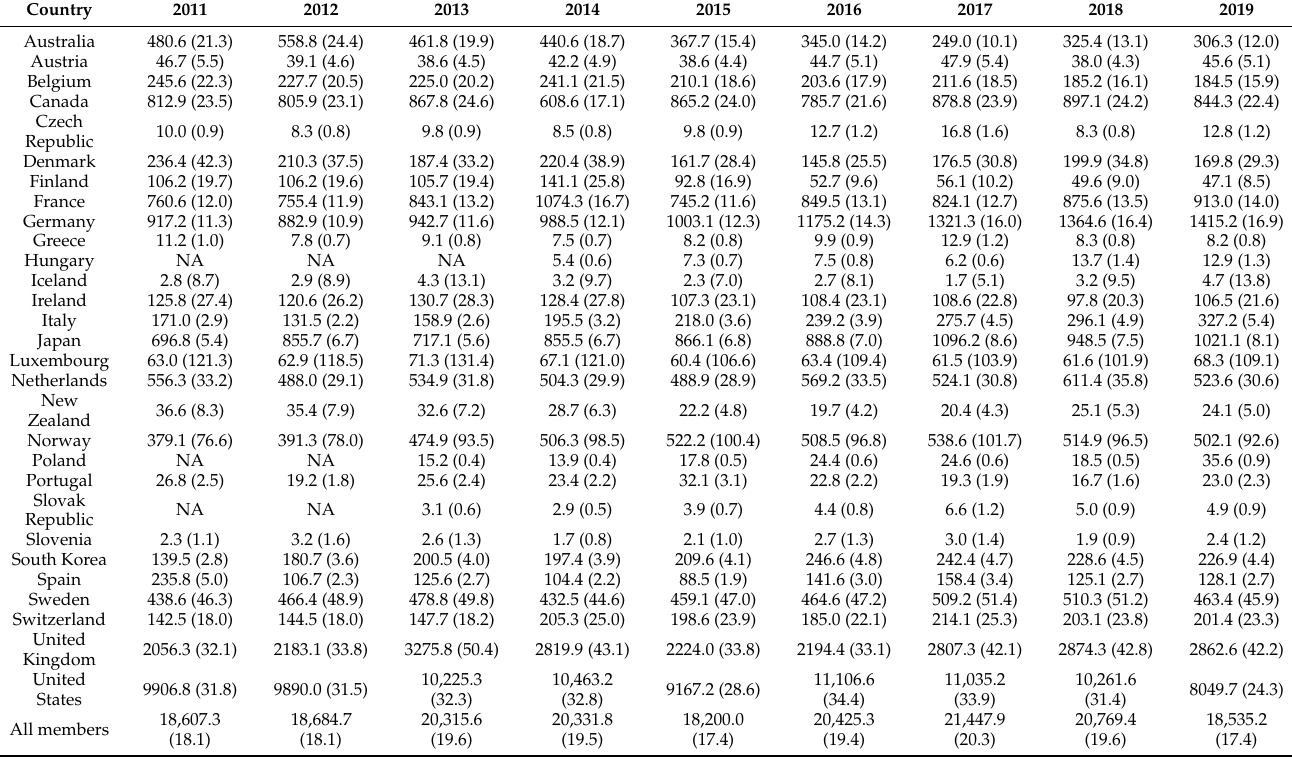
Table 1. Estimated DAH in million USD at a constant price of 2019 (per capita) from all the 29 DAC member countries,